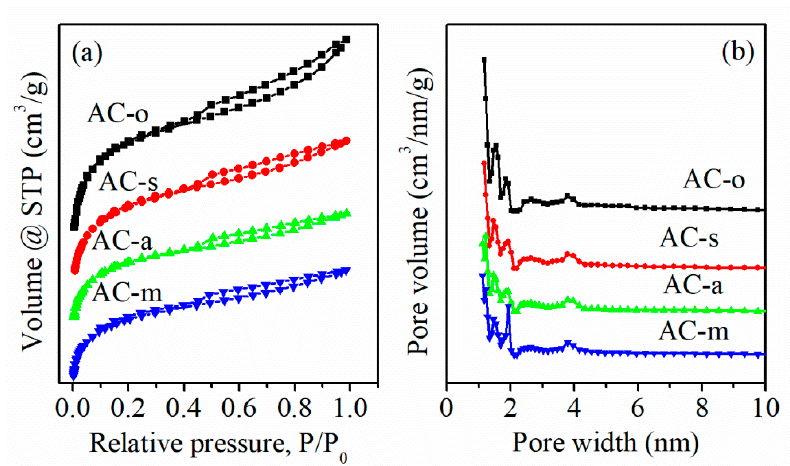
Figure 1. N 2 adsorption/desorption isotherms ( a ) and pore size distributions of the samples using DFT model ( b ). Table 1. Structural parameters calculated from N 2 adsorption/desorption isotherms.